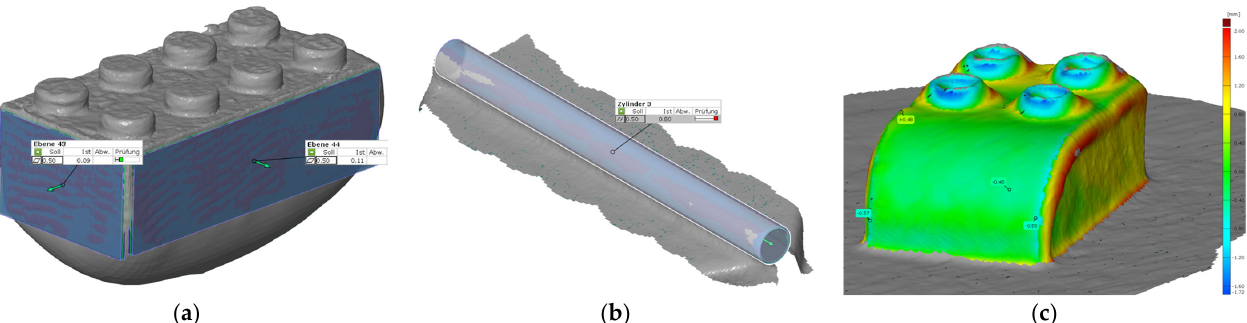
Figure 2. Examination of deviation with GOM Inspect Suite 2020: ( a ) flatness test by a scanned Lego brick with the Artec Space Spider whether colors influence the scan quality scanned; ( b ) form tolerance analysis of a Lego brick scanned by the TrueDepth camera; ( c ) target-actual comparison of a Lego brick scanned by the TrueDepth camera for the examination of scan accuracy of a profile on a surface.